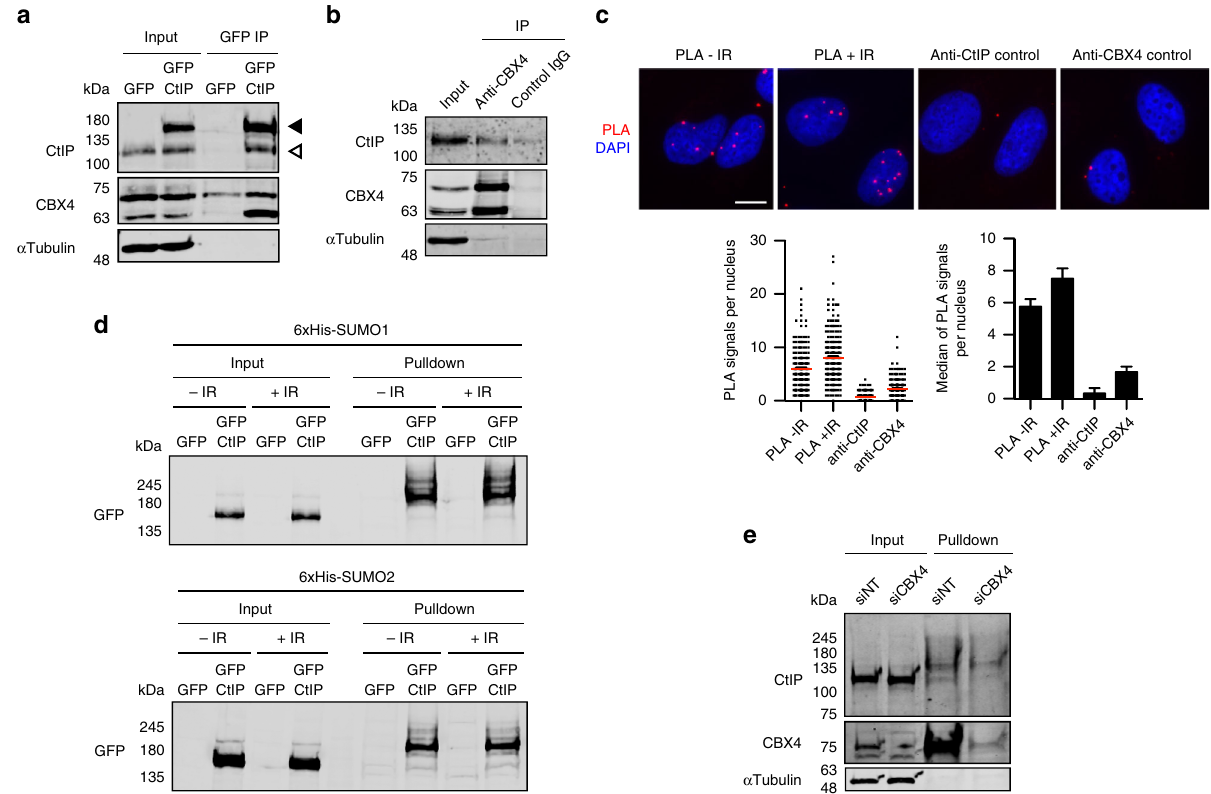
Fig. 2 CBX4 interacts and sumoylates CtIP. a GFP immunoprecipitation (IP) of protein extracts derived from U2OS cells expressing GFP-CtIP or GFP were blotted with the indicated antibodies. Input represents 5% of the total amount of protein in the IP. Endogenous CtIP and GFP-CtIP are denoted with an empty arrow and a fi lled arrow, respectively. A representative experiment is shown. b Endogenous CBX4 was immunoprecipitated from U2OS cells using an antibody against CBX4. Protein samples were resolved in SDS-PAGE and blotted with the indicated antibodies. An IgG control was included to show binding speci fi city. Input represents 5% of the total amount of protein. c PLA assay between CtIP and CBX4 in undamaged cells ( – IR) and cells 1 h after exposure to 10 Gy ionizing radiation (+IR). To assess speci fi city, cells were subjected to the same assay but with addition of only the CtIP or the CBX4 antibody. The white scale bar represents 10 μ M. A representative experiment is plotted in the left graph; the median number of PLA signals is in red . The average and SEM of the median PLA signals corresponding to three independent experiments are plotted in the right graph. d HEK293T cells harboring GFP or GFP-CtIP and 6 × His-SUMO1 or -SUMO2 constructs, either untreated ( – IR) or irradiated with 10 Gy (+IR), were used for His pulldowns, and protein samples were blotted with GFP antibody. Inputs represent 1% of the total amount of protein in the pulldowns. A representative experiment is shown. e U2OS cells stably expressing 10 × His-SUMO1 were transfected with siCBX4 or a control siRNA (siNT) and used for His pulldowns. Input represents 5% of the total amount of protein in the pulldown. A representative experiment is